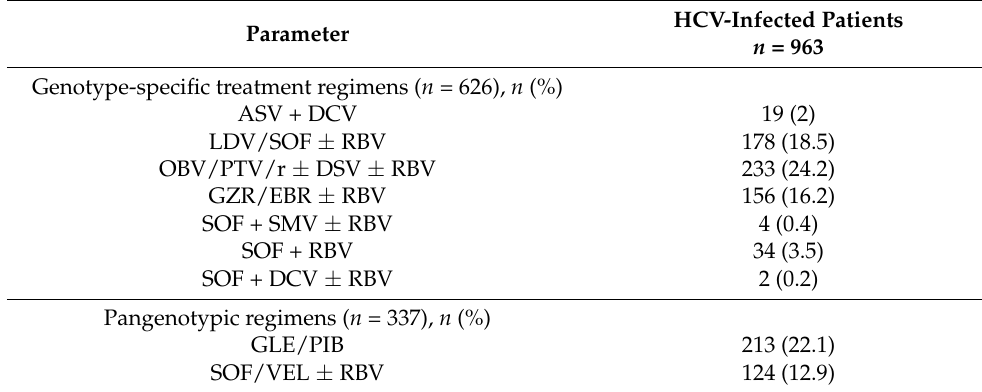
Table 3. Therapeutic Regimens Used in the Analyzed Population.